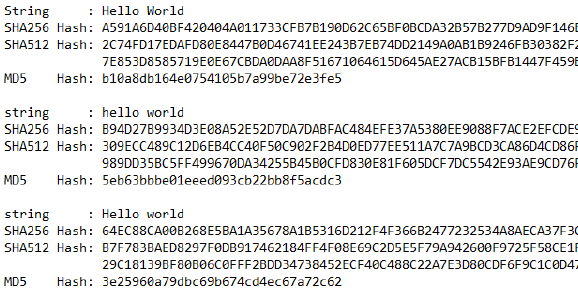
Figure 2. Hash values generated by different Hashing Algorithms.